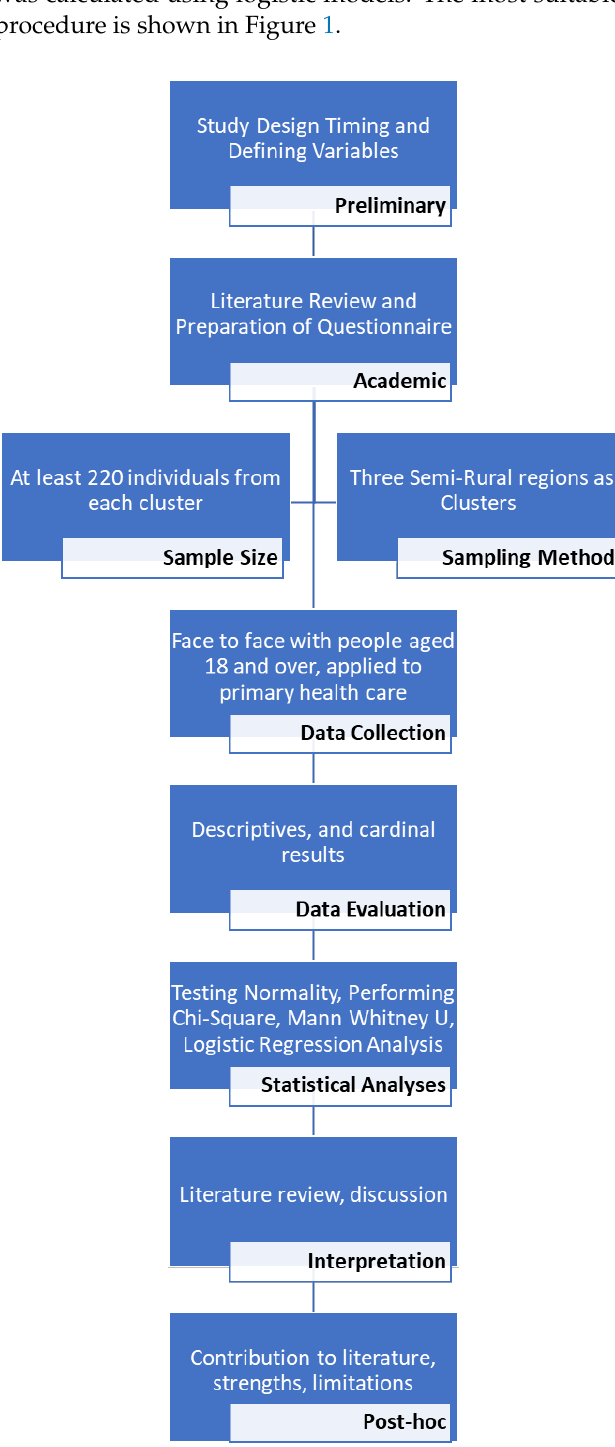
Figure 1. The study procedure.